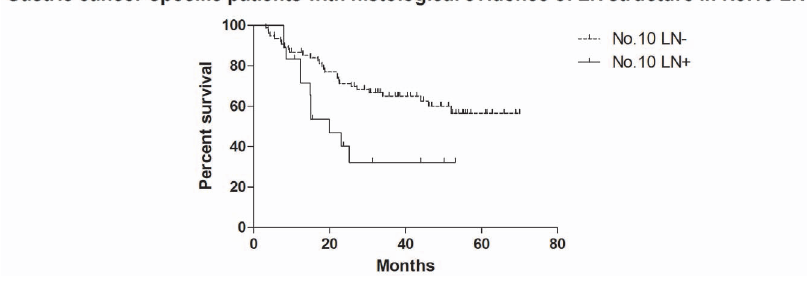
Figure 7. Kaplan-Meier survival analysis of gastric cancer specific group in patients with histological evidence of LNs structure in No.10 LNs.